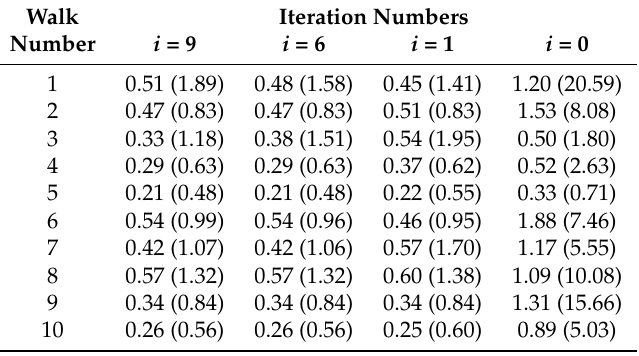
Table 3. Mean position error ¯ e and maximum error e max (in brackets) of 10 different walks with 6 sensors mounted on the foot for partly successive FeetSLAM with different number of iterations i . The window size s was